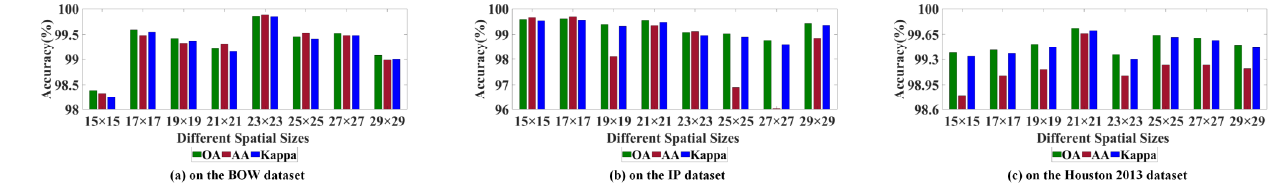
Figure 8. The classification results of different spatial sizes.